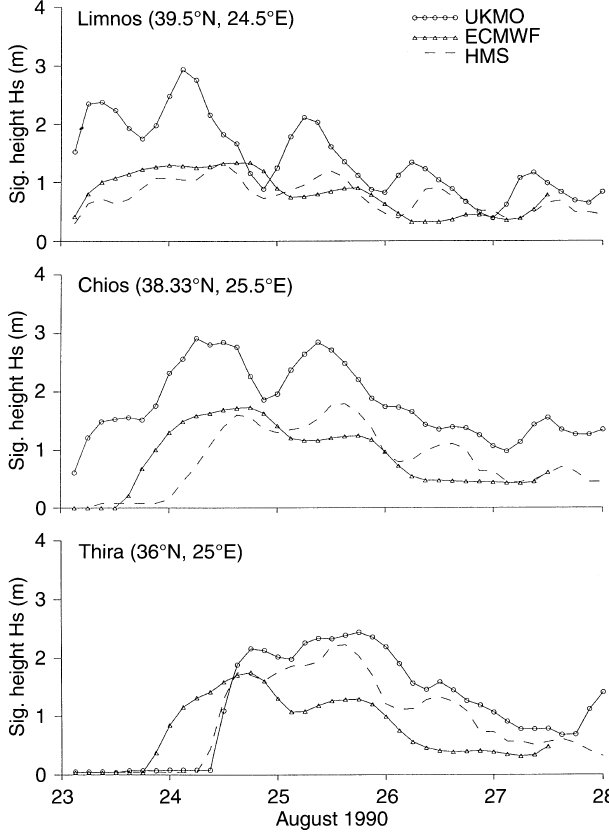
Fig. 5. Wave heights at specific grid points, August 1990 (UKMO v. ECMWF)